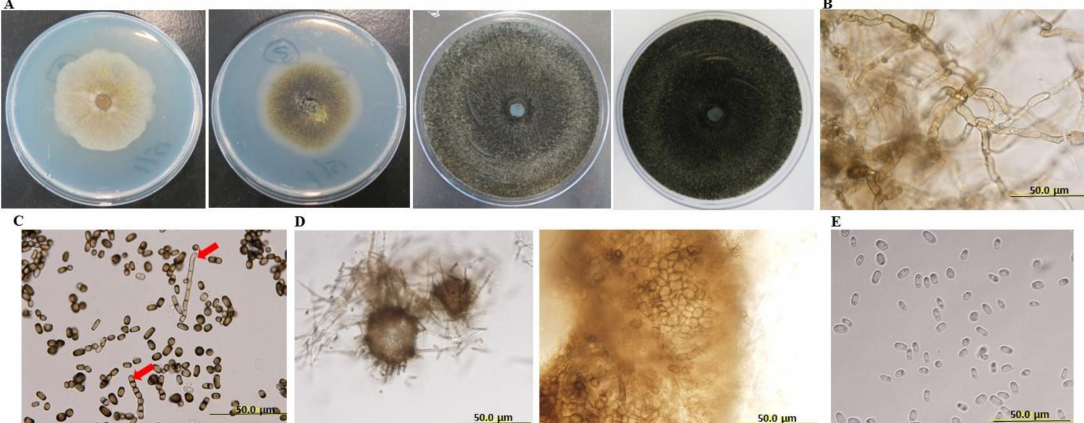
Figure 2. Cultural and morphological characteristics of Neoscytalidium dimidiatum . ( A ) Colonies on PDA (left to right: 2, 4, 8 and 12 days of incubation at 25 ± 2 ◦ C); ( B ) mycelia; ( C ) scytalidium-like anamorph showing various shapes and maturity stages of arthroconidia (red arrows) segmenting from hyphae; ( D ) pycnidia formed on a 25-day-old colony (left) and pycnidiospores (right) on PDA; and ( E ) fusicoccum-like pycnidial conidia